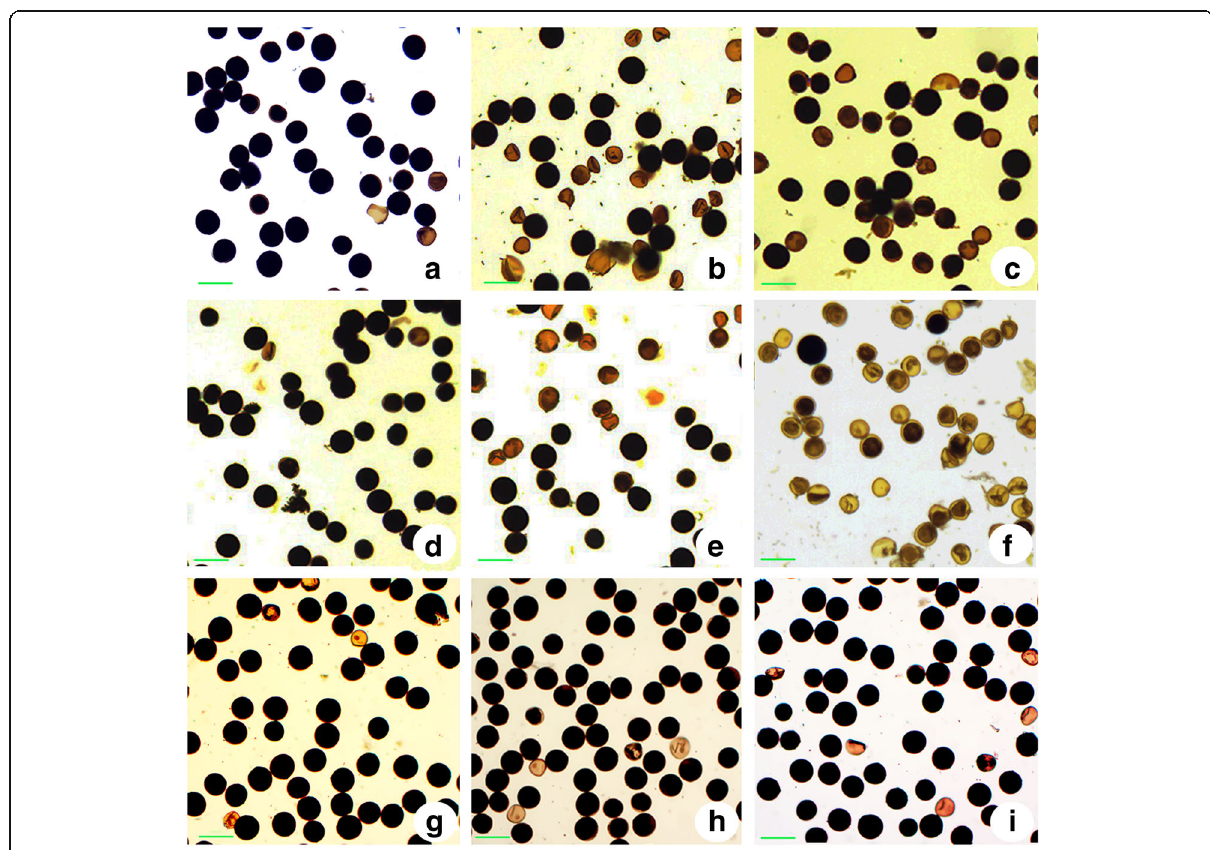
Fig. 1 Pollen sterility caused by the interaction of different pollen sterility loci. a Pollen phenotypes of Taichung65-4×. b Pollens of a hybrid with interaction at Sa locus. c Pollens of a hybrid with interaction at Sb locus. d Pollens of a hybrid with interaction at Sc locus. e Pollens of a hybrid with double loci ( SaSb ) interaction. f Pollens of a hybrid with triple loci ( SaSbSc ) interaction. g Pollens of a hybrid (T449-4××E1-4×) with no-interaction at Sa and Sb pollen sterility loci, but interaction exists at Sc pollen sterility locus. h Pollens of a hybrid (T449-4××E24-4×) with no-interaction at Sa and Sb pollen sterility loci, but interaction exists at Sc pollen sterility locus. i Pollens of a hybrid (T449-4××E24-4×), with no-interaction at Sa , Sb and Sc pollen sterility loci. Bars=10 μ